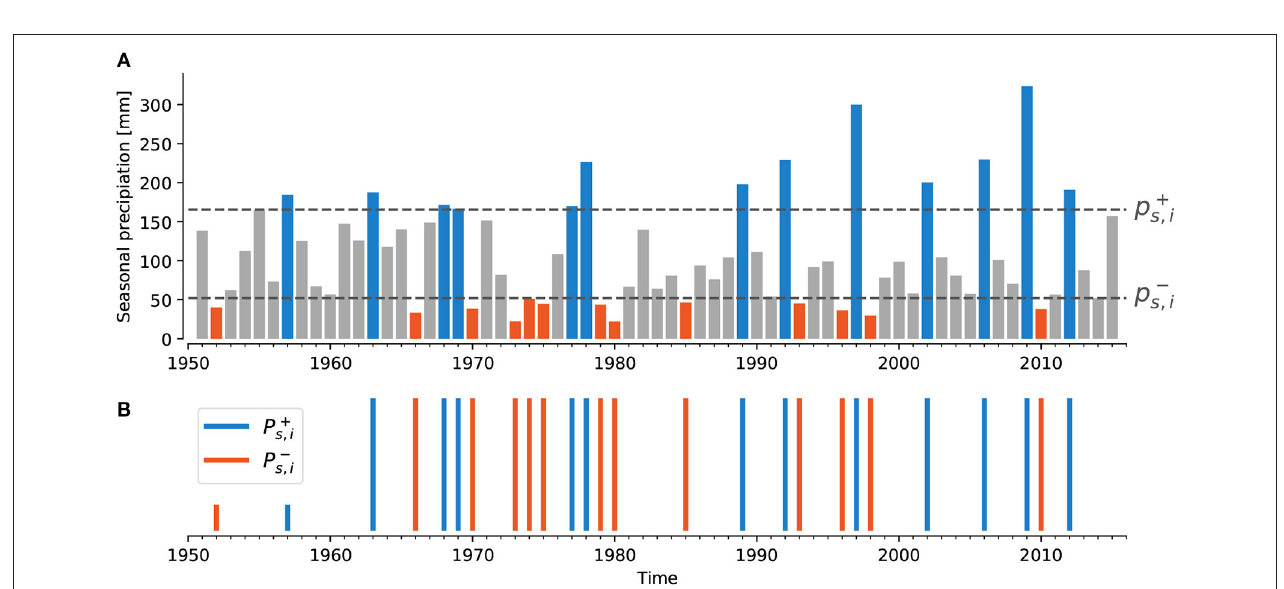
and p − s computed as the 80th and 20th i i